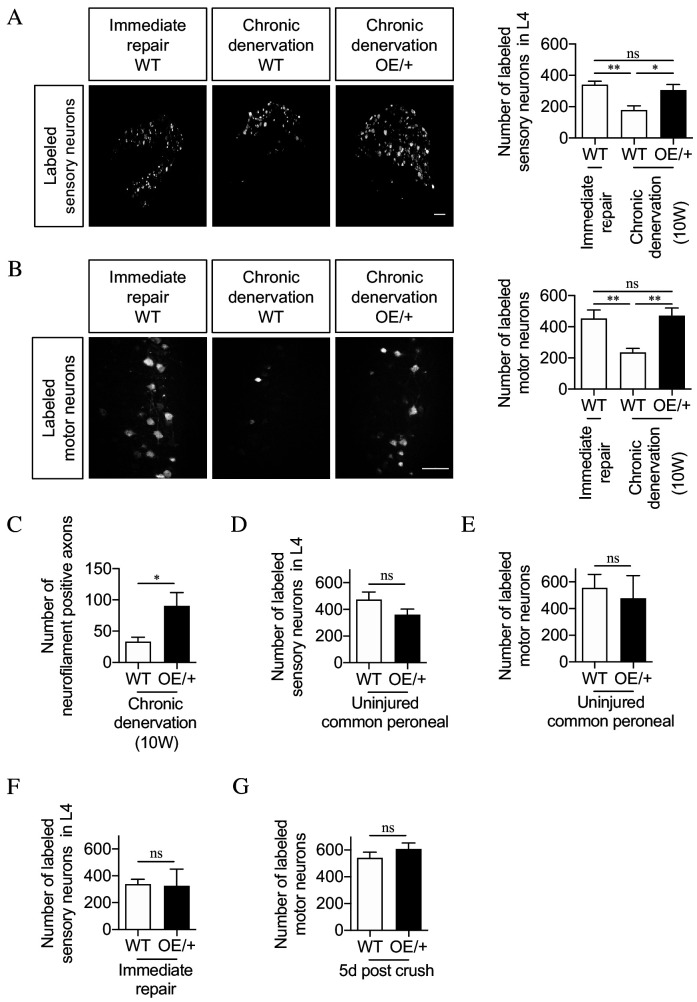
The regenerative capacity of c-Jun OE/+ nerves is maintained during chronic denervation.(A) Representative images showing Fluorogold-labeling of neurons in L4 DRGs of WT and c-Jun OE/+ mice after 2 weeks of regeneration into acutely transected (immediate repair) or chronically denervated (10 weeks) distal stumps. Quantification by cell counting is in the graph. The number of back-filled DRG neurons following regeneration through chronically denervated WT stumps was reduced, but maintained after regeneration through chronically denervated c-Jun OE/+ stumps. One-way ANOVA with Tukey’s multiple comparison test; **p<0.005, *p<0.05, ns non-significant. WT immediate repair and chronic denervation n = 6, OE/+ chronic denervation n = 8. (B) Representative images showing Fluorogold- labeling of back-filled motor neurons in WT and c-Jun OE/+ mice after 2 weeks of regeneration into acutely transected (immediate repair) or chronically denervated distal stumps. Quantification is in the graph, showing that compared to immediate repair, the number of labeled neurons is reduced after regeneration through chronically denervated WT stumps, but not after regeneration through chronically denervated c-Jun OE/+ stumps. One-way ANOVA with Tukey’s multiple comparison test; **p<0.005. WT immediate repair and chronic denervation n = 6, c-Jun OE/+ chronic denervation n = 8. (C) Counts of neurofilament+ immunofluorescent fibers in the distal stump 1 week after repair following chronic denervation of WT and c-Jun OE/+ nerves. In parallel experiments, the number of neurofilament+ fibers in WT nerves after immediate repair was about 200 (see Figure 2D). Unpaired Student’s t-test; *p=0.0334. WT n = 4, c-JunOE/+ n = 3. (D, E) Counts of Fluorogold-labeled sensory (D) and motor (E) neurons in WT and c-Jun OE/+ mice following transection with immediate application of tracer. The number of back-filled sensory (p=0.1872) and motor (p=0.7153) neurons is similar. Unpaired Student’s t-tests, n = 3 for each experimental condition. (F) The number of back-filled sensory neurons in WT and c-Jun OE/+ mice is similar after transection followed by immediate repair. Unpaired Student’s t-test; p=0.9195. n = 3. (G) The number of labeled motor neurons in WT and c-Jun OE/+ mice is similar when tracer was applied 5 days after sciatic nerve crush. Unpaired Student’s t-test; p=0.312. WT n = 5, c-Jun OE/+ n = 4. All numerical data represented as means ± SEM, all scale bars: 100 µm.